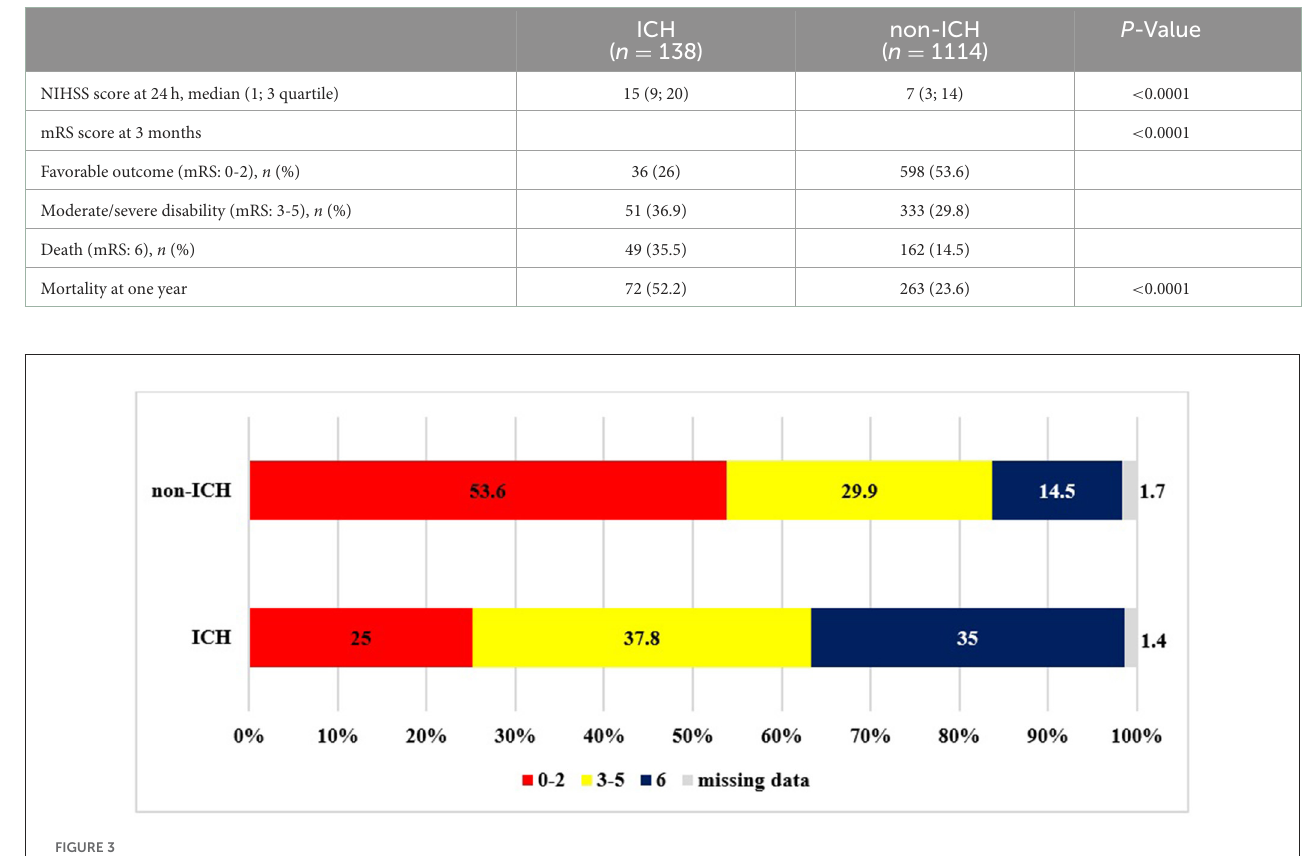
FIGURE3 Outcome at 3 months based on mRS (ICH: intracranial